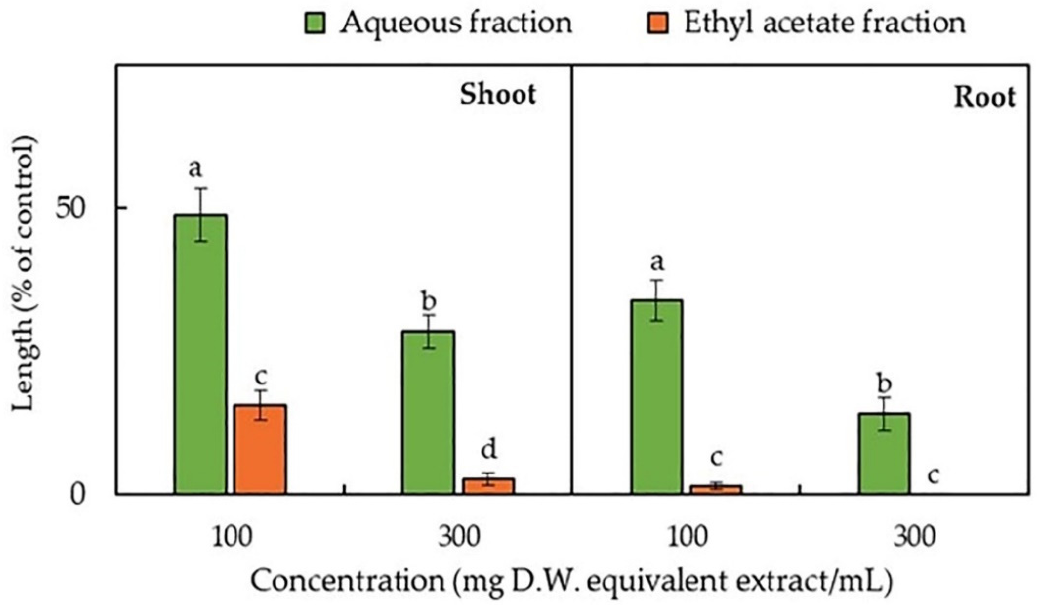
Figure 4. The inhibitory activity of the aqueous and ethyl acetate fractions obtained from the Dregea volubilis leaf extracts on the shoot and root growth of cress. The bars on each experiment express mean ± SE with three replicates ( n = 30). The different letters indicate significant differences among the treatments (Tukey’s HSD, p < 0.05).